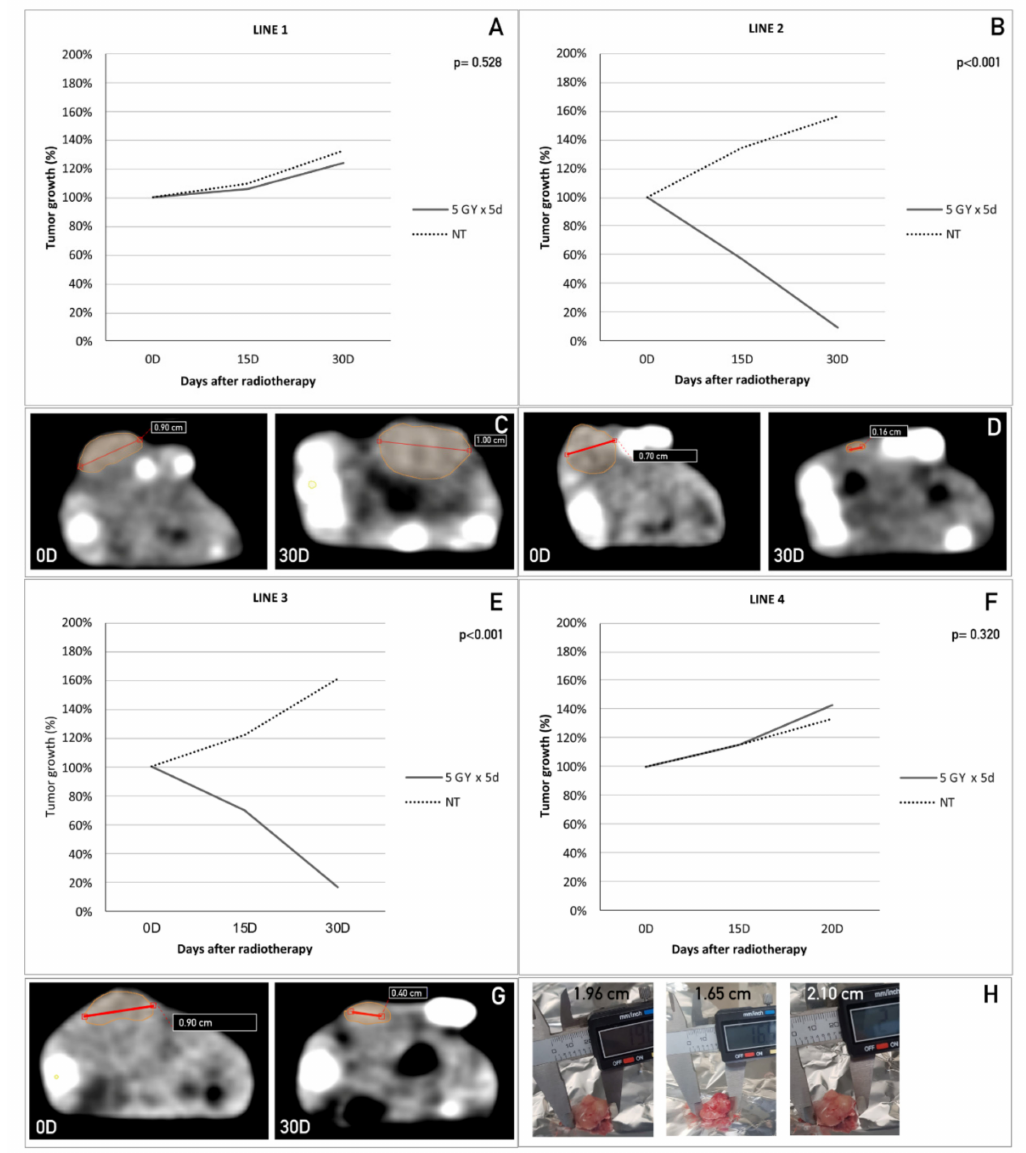
Figure 3. CSCs from di ff erent rectal biopsies showed in vivo sensitivity to radiotherapy comparable to that found under in vitro treatments. Graphical representations of in vivo tumor growth (%) measured at three di ff erent time points (0D, 15D, 30D) after treatment with 5 Gy dose radiation, supplied for 5 consecutive days, in combination with a dose rate of 2400 MU / min, in comparison with not treated sample (NT), for CSC Line 1 ( A ), Line 2 ( B ), Line 3 ( E ) and Line 4 ( F ). ( C , D , G ) Representative CT scan images taken the day of the last irradiation (D0) and 30 days after treatment for line 1, 2 and 3. Line 4 produce fast growing refractory tumors with consequent risk of ulceration. All mice implanted with line 4 had to be sacrificed at day 20 because they reached tumor mass limit. For this reason, CT scan images are not available. Representative images of ex vivo measures for line 4 ( H